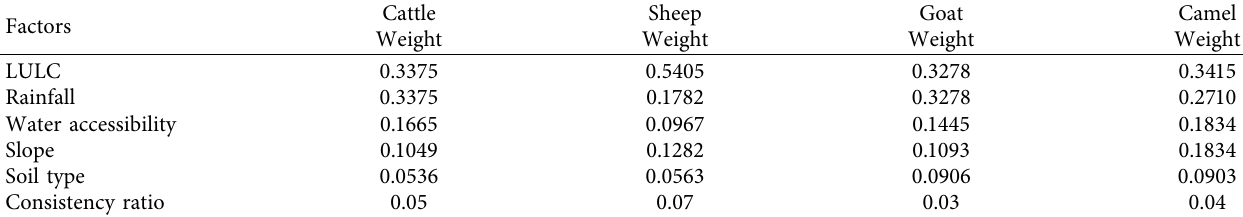
Table 2: Criteria weights of the pair-wise comparison matrix.